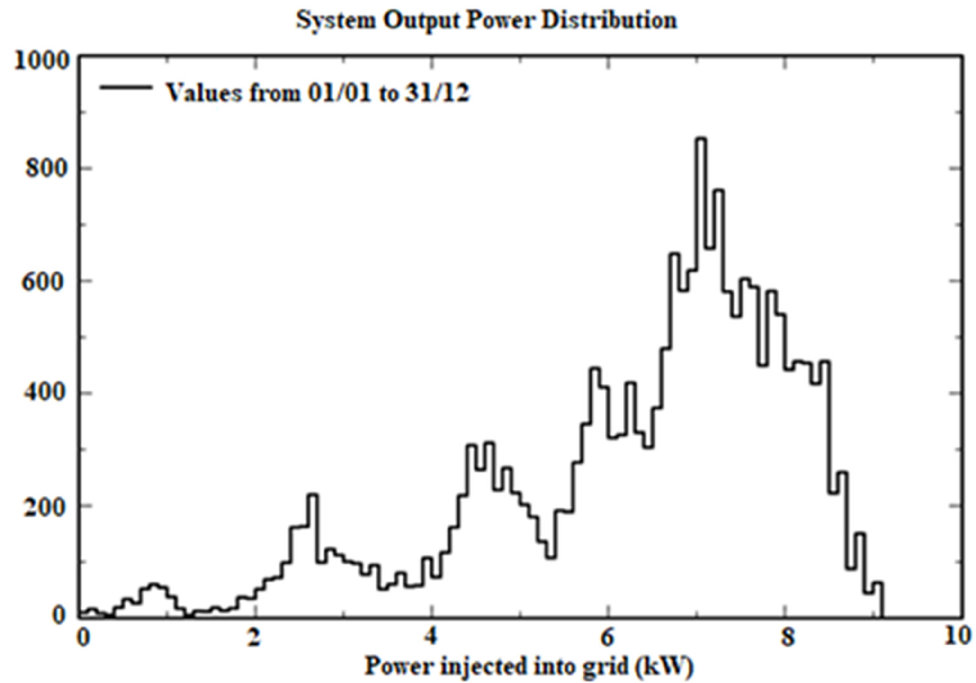
Figure 9. System output power distribution for the Meybod area.